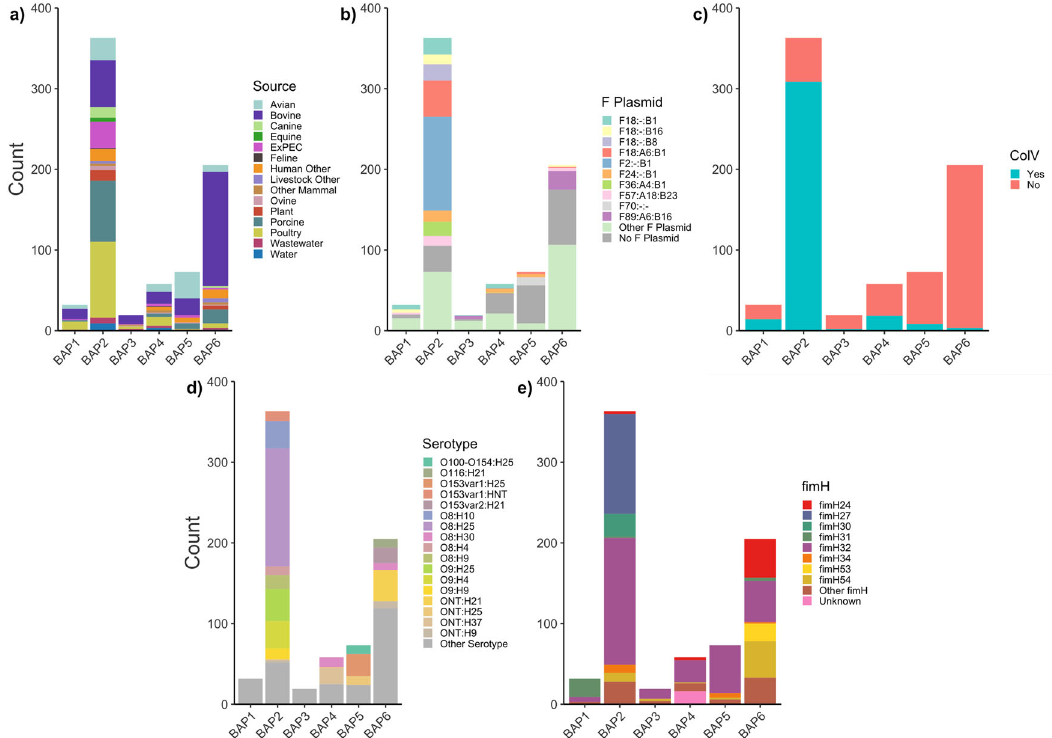
Fig. 3 Metadata distribution across BAP clusters. Distribution of a source; b F plasmid replicon sequence type (RST); c ColV carriage; d serotype and e fi mH allele by BAP cluster for 750 ST58 genome sequences.